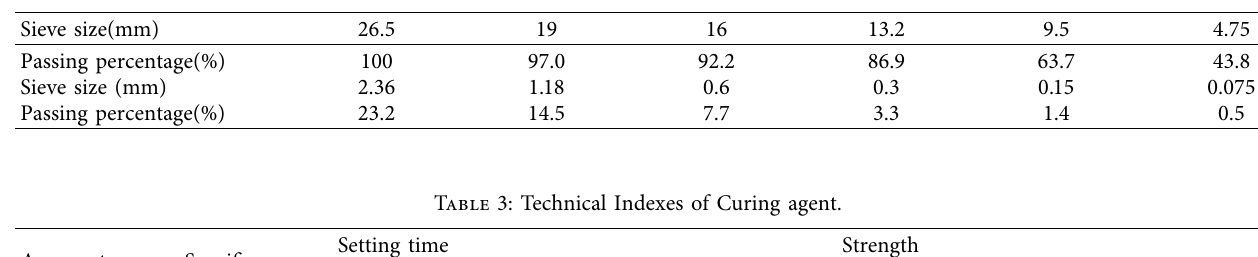
Table 2: RAI gradation.